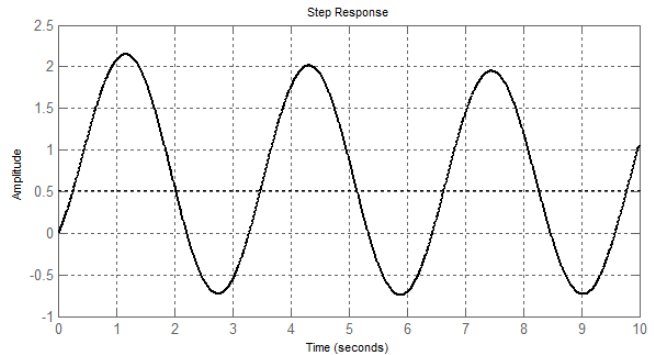
Figure 9. The transition function in this case.